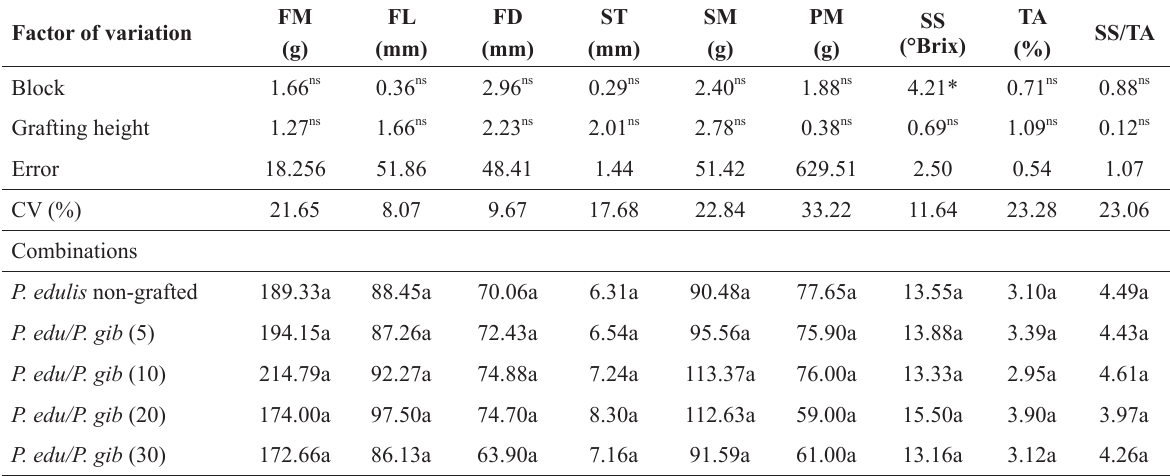
Physicochemical characteristics of fruits of Passiflora edulis plants grafted on P. gibertii at four grafting heights compared with non-grafted P. edulis